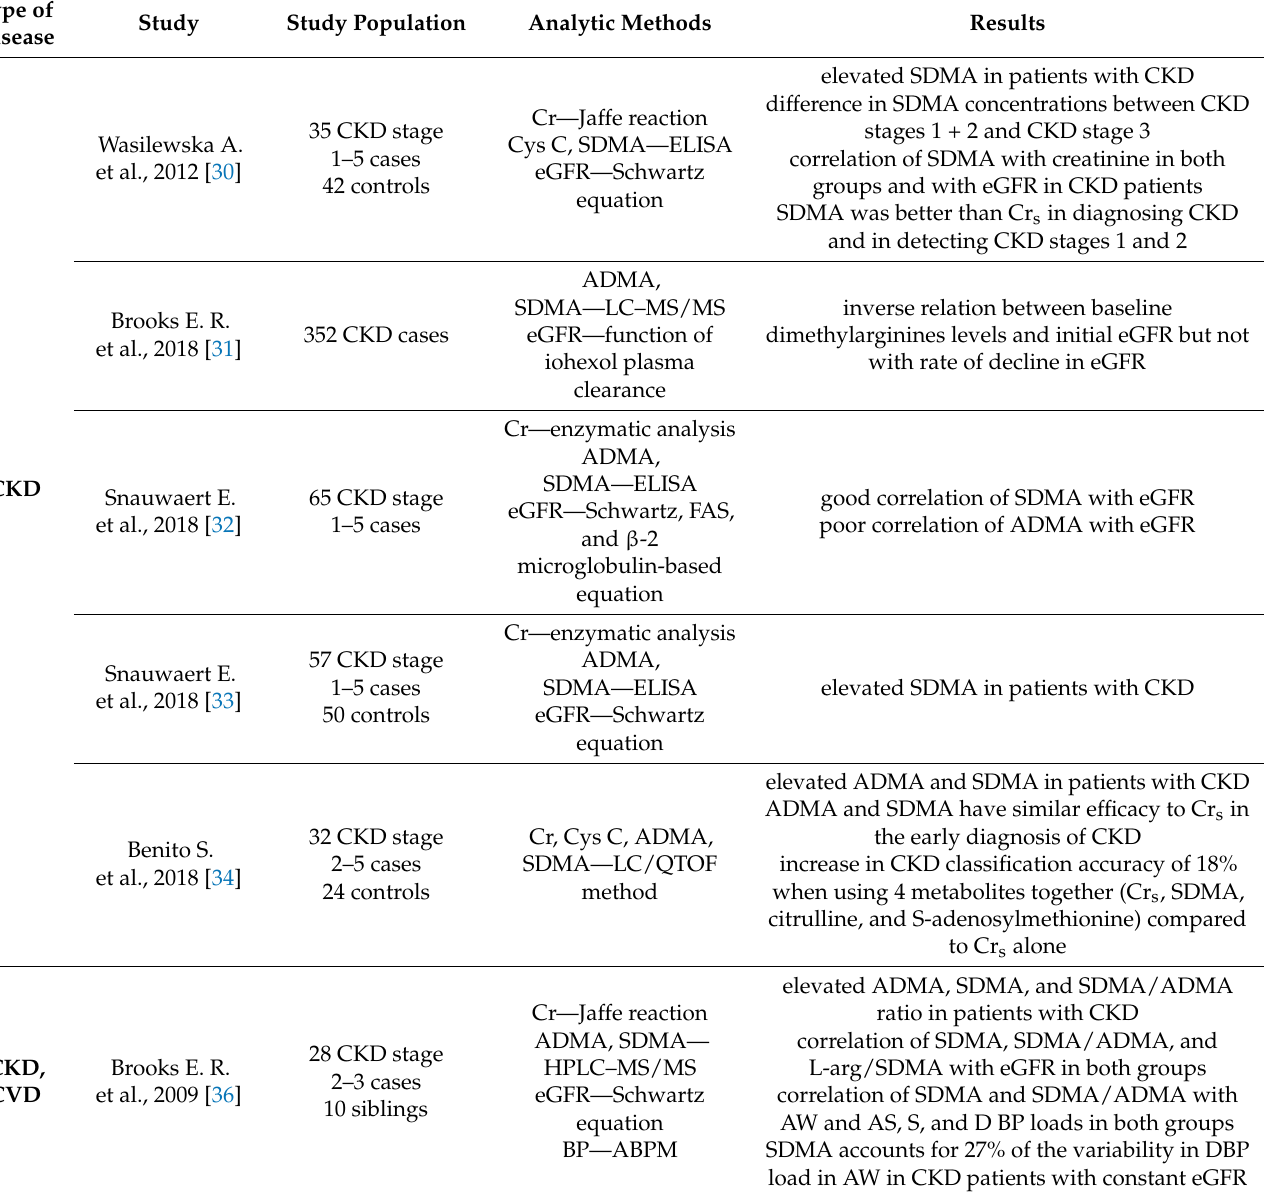
Table 1. The role of ADMA and SDMA in paediatric kidney diseases—summary of the articles and presented studies from 2003 to 2022 used in the review according to disease type, study population, used analytic methods, and key